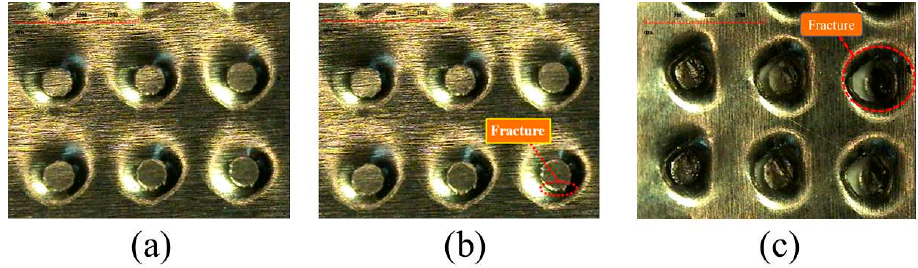
Figure 20. Processed stainless steel plate ( a ) stroke of 0.5 mm; ( b ) stroke of 0.55 mm; ( c ) stroke of 0.6 mm.